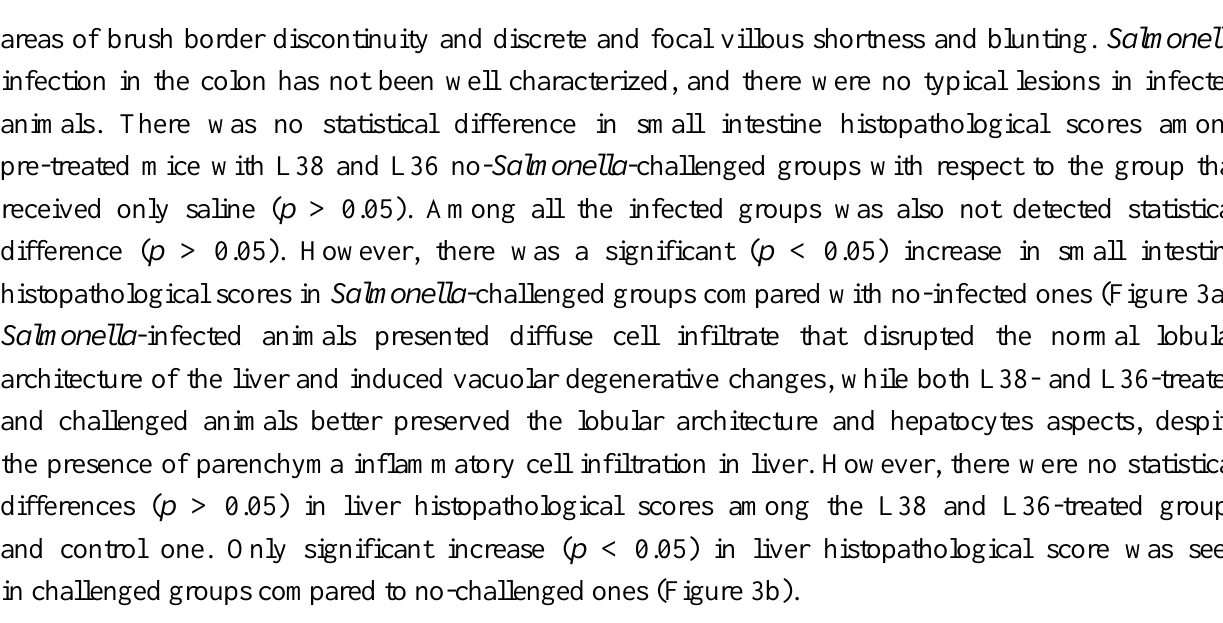
Figure 3. Histopathological scores of liver and small intestine of L38- and L36-treated mice on the 9th day post -Salmonella challenge. ( a ) Small intestine histopathological score and ( b ) Liver histopathological score. Results were expressed as mean histopathological scores according to the gradation 0 (normal) to 3 (severe) of tissue architecture damage ( n = 10 per group). The vertical bars indicate the standard deviation of means.